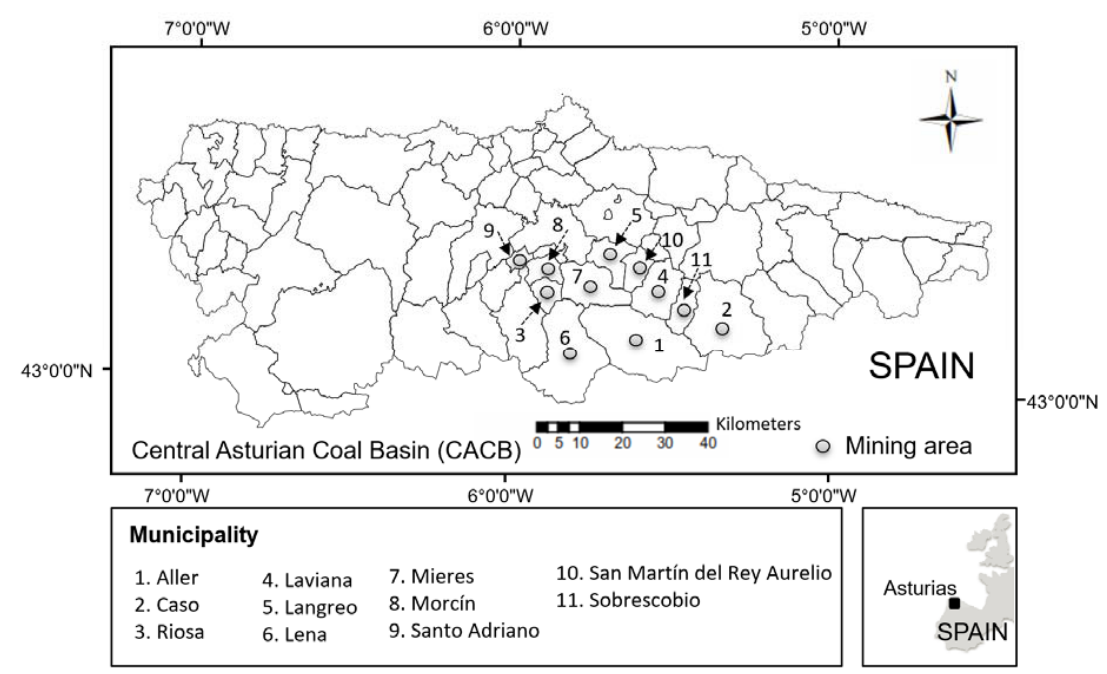
Figure 1. Location of the study area—Principality of Asturias (Spain).